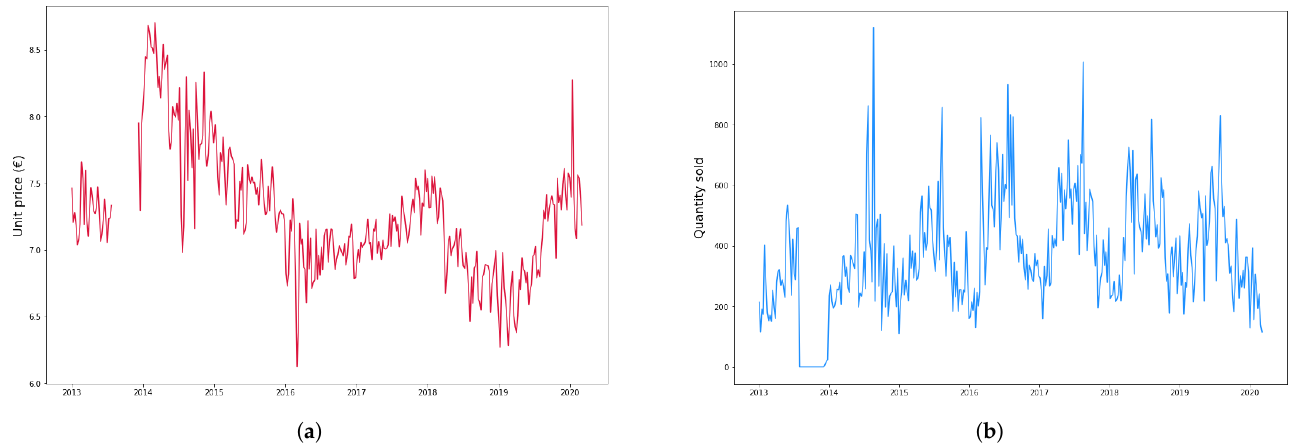
Figure 4. ( a ) Unit price and ( b ) sold quantity time series for product 3 after resampling with weekly